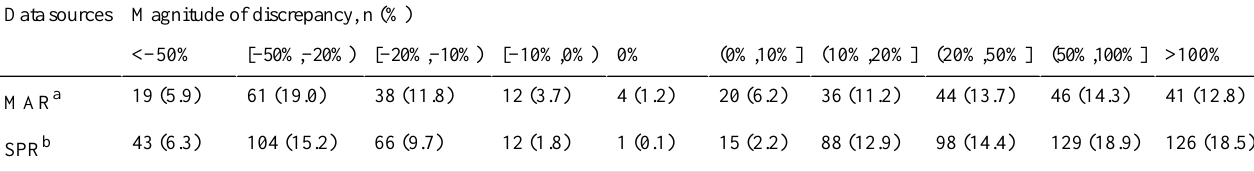
Table 4. Magnitude of discrepancy for medication administration records and smart pump records across all medications. Magnitude of discrepancy, n (%)Data